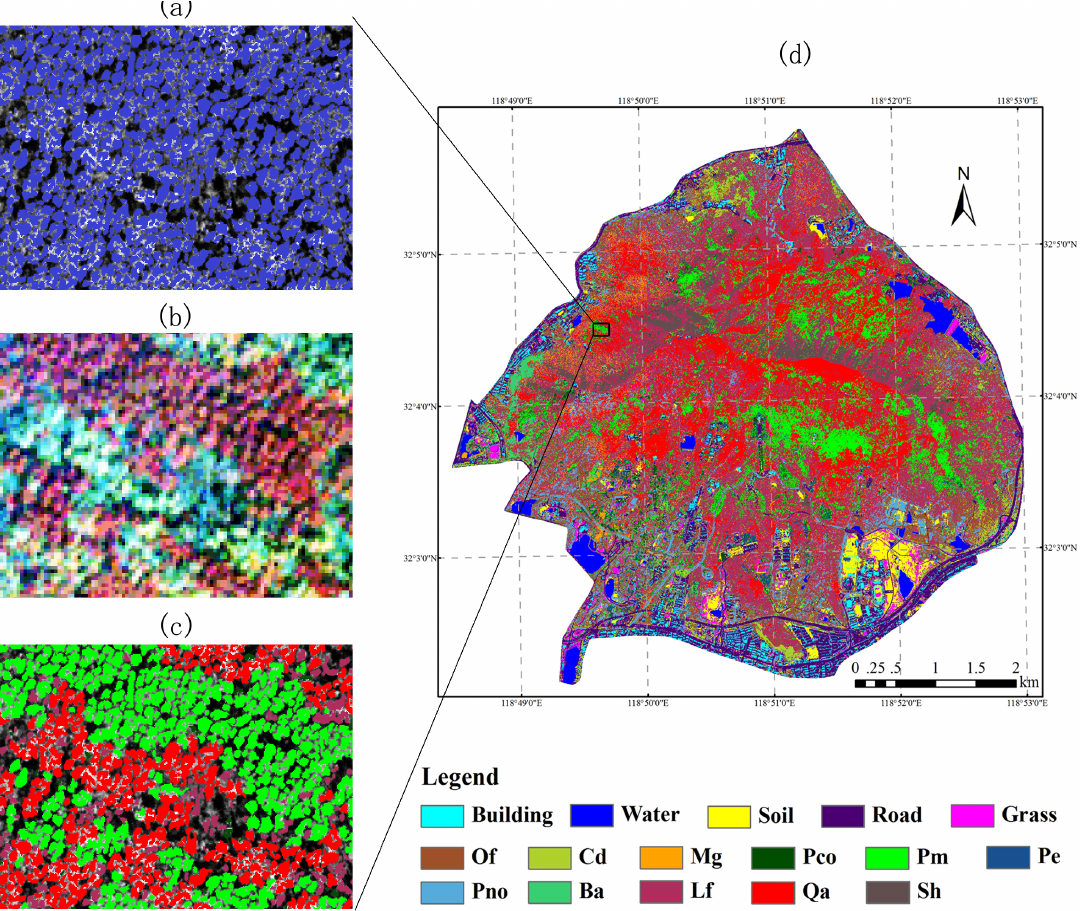
Figure 8. Distribution of tree species classified by the crown-based approach for eight multispectral bands. ( a ) the magnified area displayed by delineated tree crowns overlaying the panchromatic band; ( b ) the magnified area displayed by R: G: B = 7(NIR1): 5(Red): 2(Blue); ( c ) the magnified area displayed by object-based classified tree crowns overlaying the panchromatic band; ( d ) the crown-based classification map of tree species at Purple Mountain by overlaying the non-forested classes. The abbreviations are the same as in Figure